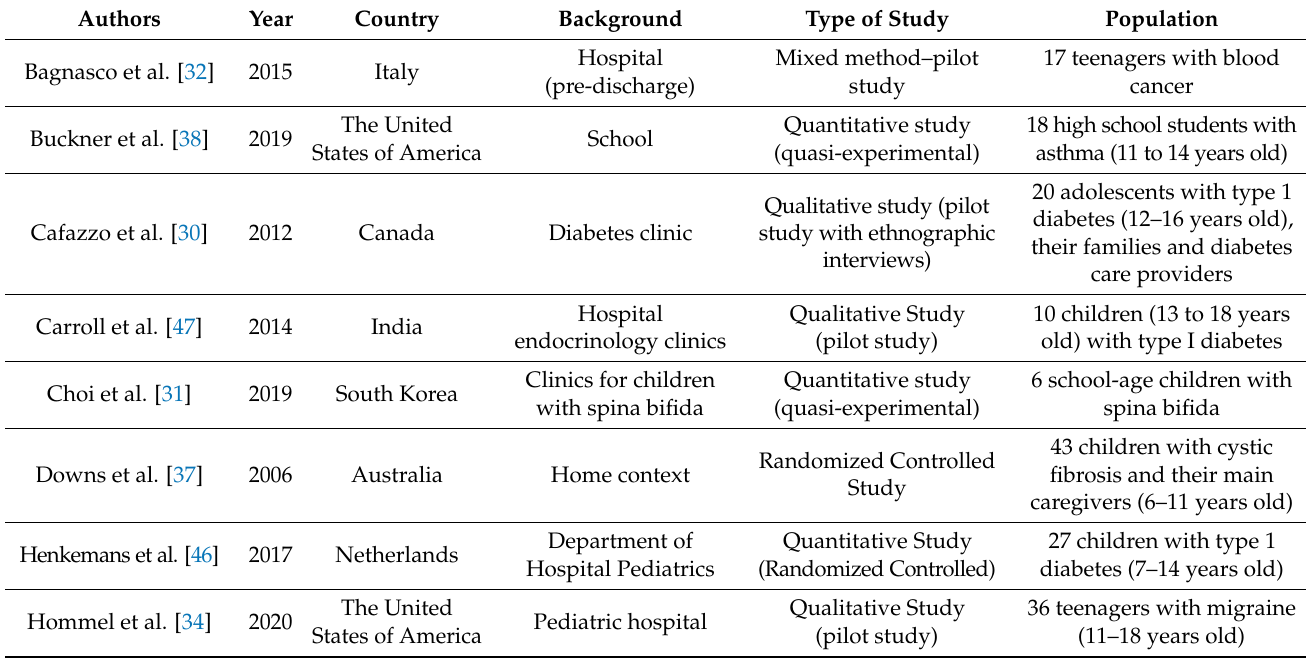
Table A3. Characteristics of the articles included in this scope